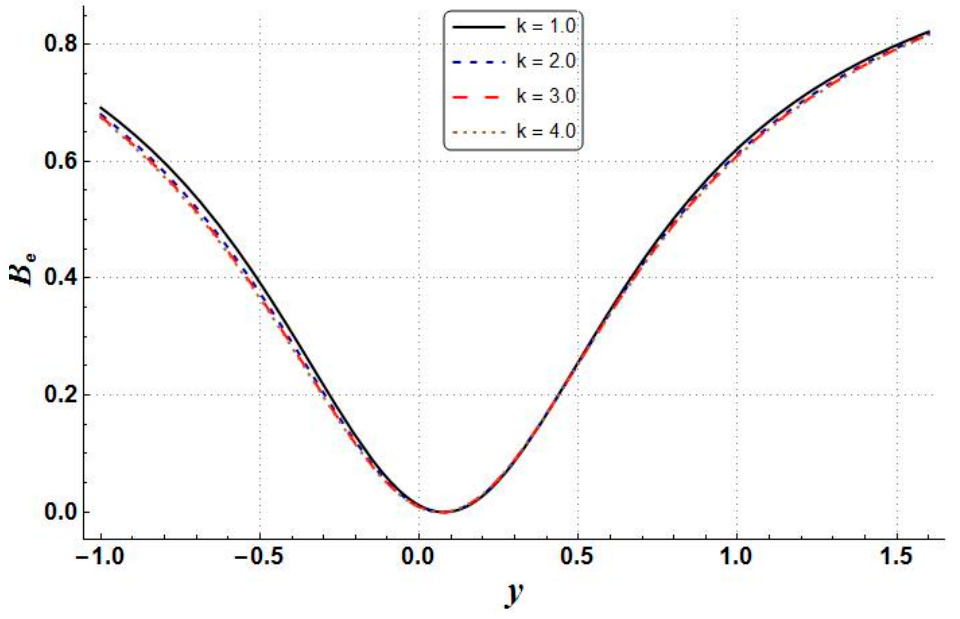
, x = 0, Gr = 2, α = π , 4 4 ∈ , where